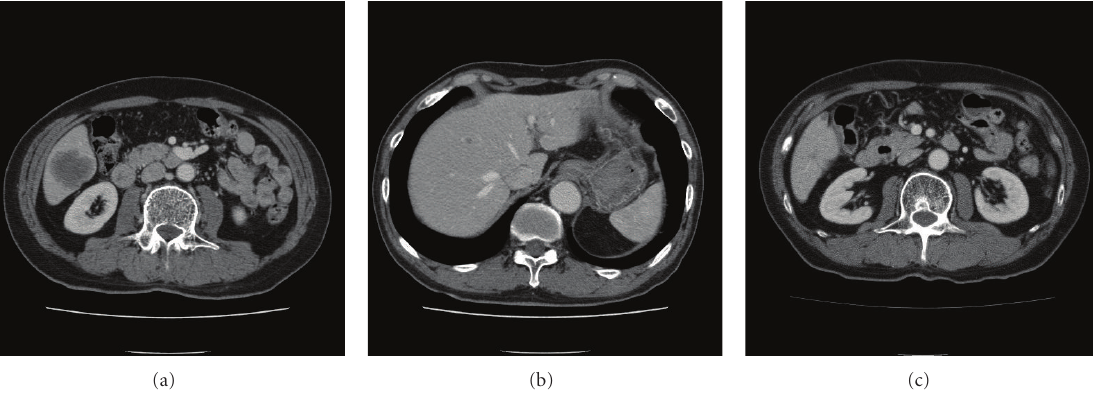
Figure 1: Abdominal computed tomography. Computed tomography revealed longest diameter 40mm-sized hepatic mass in the posterior inferior segment of the liver (a) and small nodules scattered throughout both hepatic lobes (b). After 6 courses administration of amrubicin as a third-line chemotherapy, the mass decreased